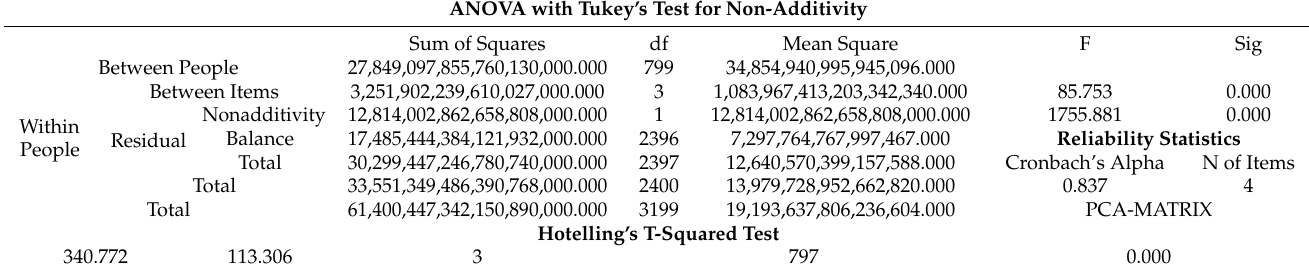
Table 6. The results of the first sub-factor (F1.1) of sustainable profit in businesses through reliability